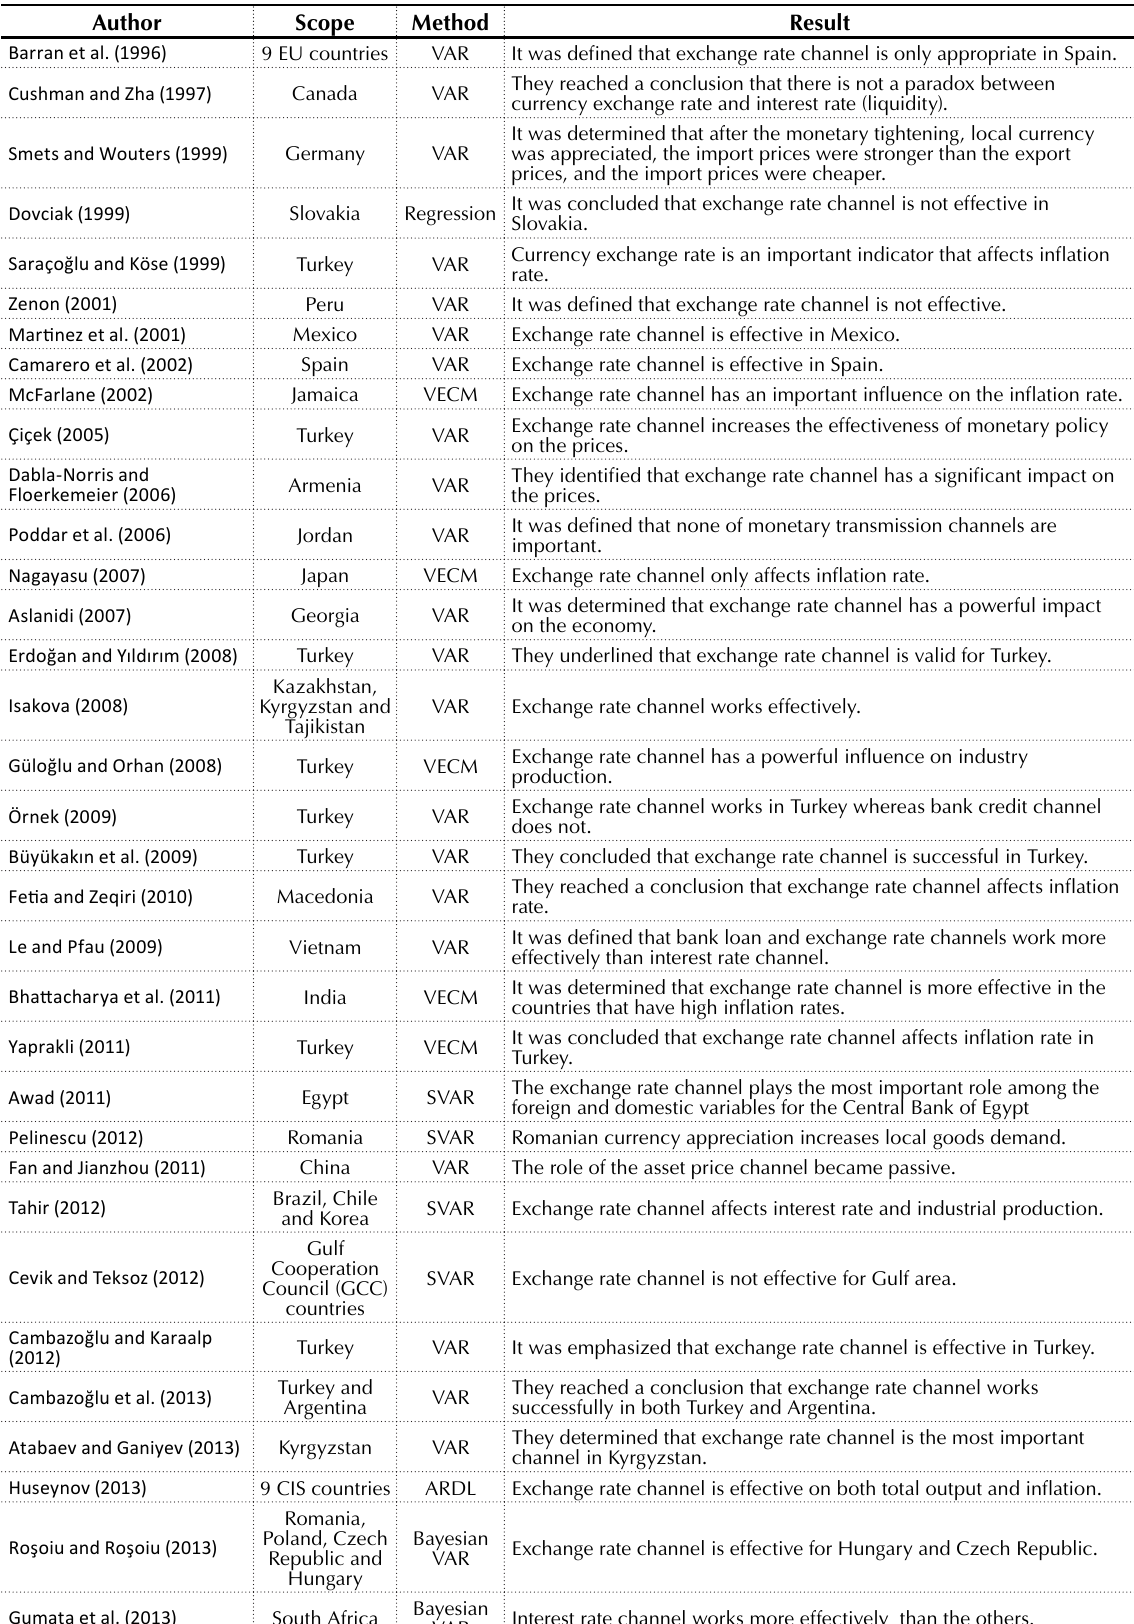
Table 1. Selected studies for exchange rate